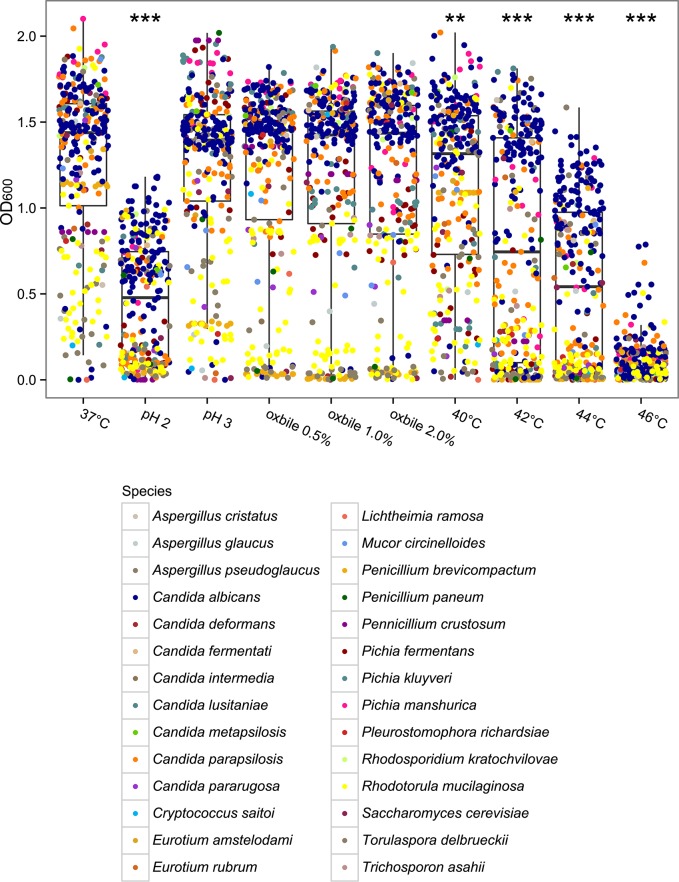
Box-plot representation of the comparison of fungal isolates growth ability at 37°C (control condition) vs. different stressful conditions mimicking the gastrointestinal tract challenges. **p < 0.0005, ***p < 0.0001, Wilcoxon rank-sum test.